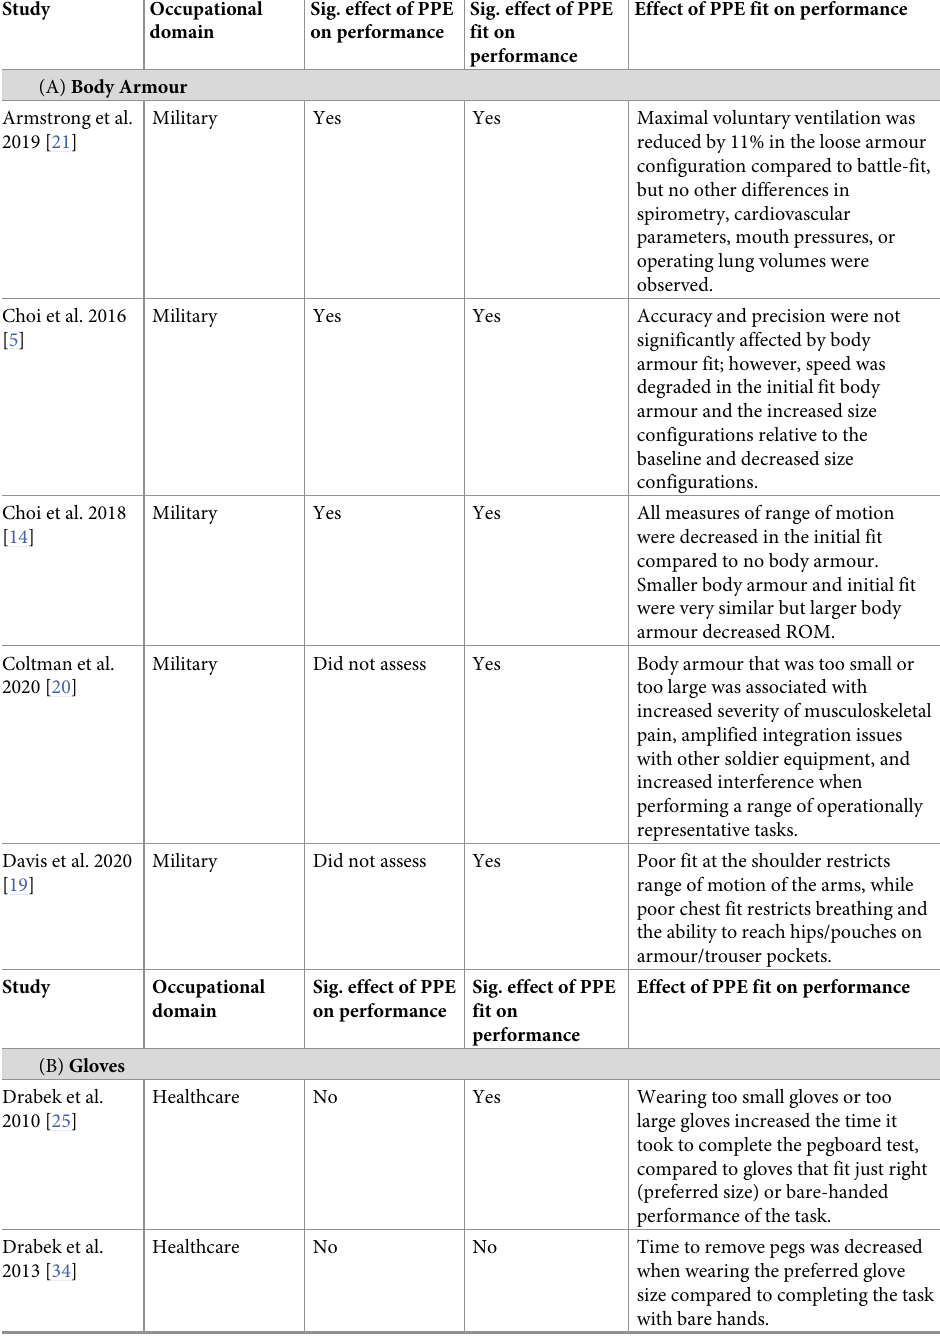
Table 4. Key findings from the 16 studies included in the present review regarding the effect of PPE fit on perfor- mance of (A) body armour; (B) gloves; (C) helmets; (D) spacesuits; and (E)